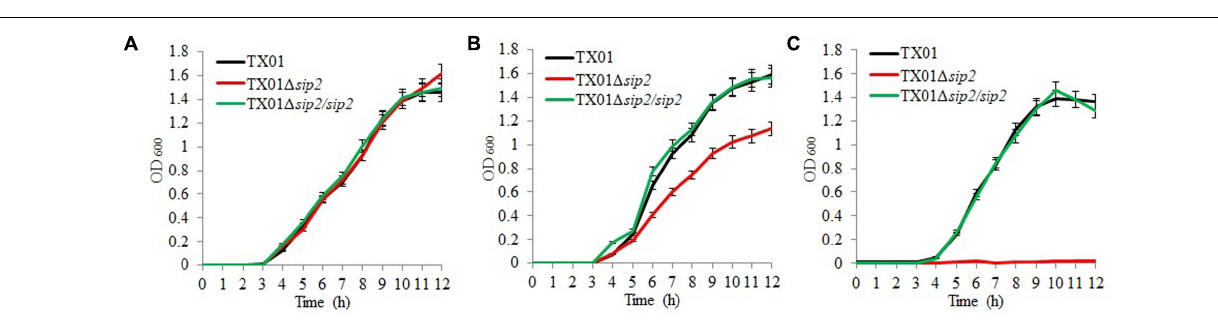
FIGURE 4 | Effect of pH and iron on the growth of Edwardsiella tarda . (A,B) E. tarda TX01, TX01 (cid:49) sip2 , and TX01 (cid:49) sip2 / sip2 were cultured in LB medium at pH 7 (A) or pH 6 (B) , and bacterial growth was monitored at different time points. (C) E. tarda TX01, TX01 (cid:49) sip2 , and TX01 (cid:49) sip2 / sip2 were cultured in iron-depleted LB medium at pH 7, and bacterial growth was monitored as above. For all panels, data are the means of three independent assays and presented as means ±